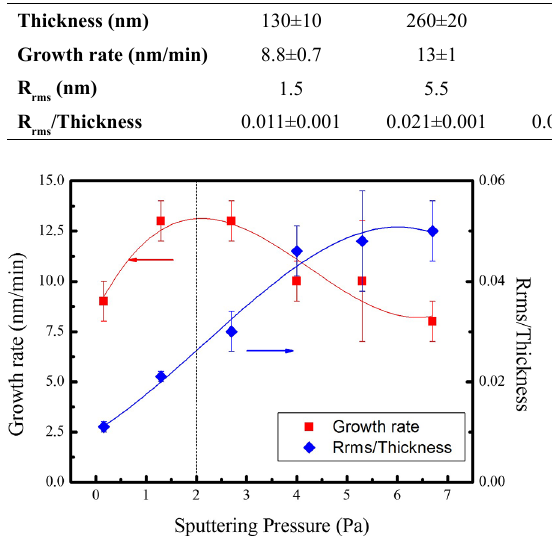
Figure 2. Growth rate and RMS/thickness ratio as a function of the sputtering pressure for AZO